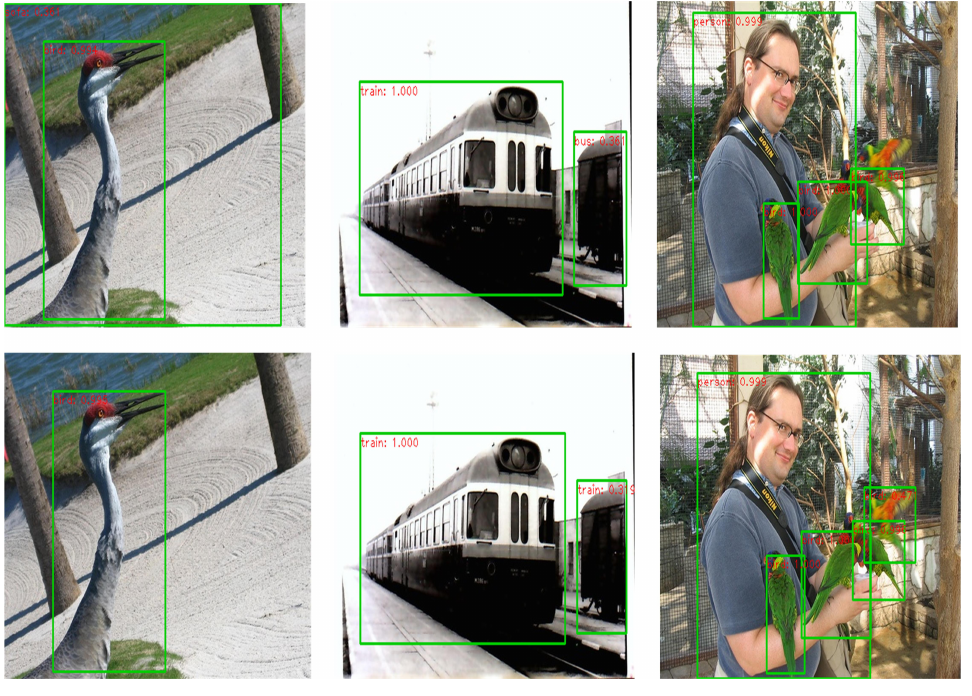
Figure 5. The typical result images of target detection, the first row is from the benchmark algorithm, and the second row is from the proposed